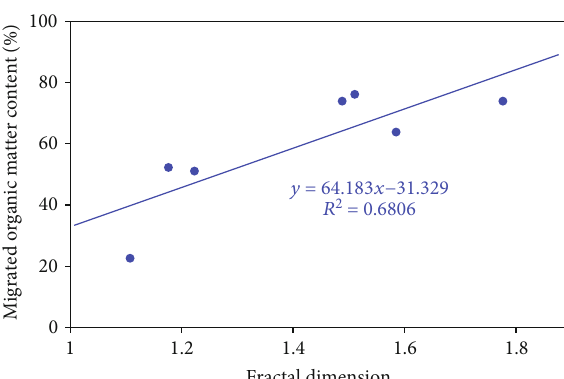
Figure 8: The relationship between the fractal dimension and migrated organic matter contents.